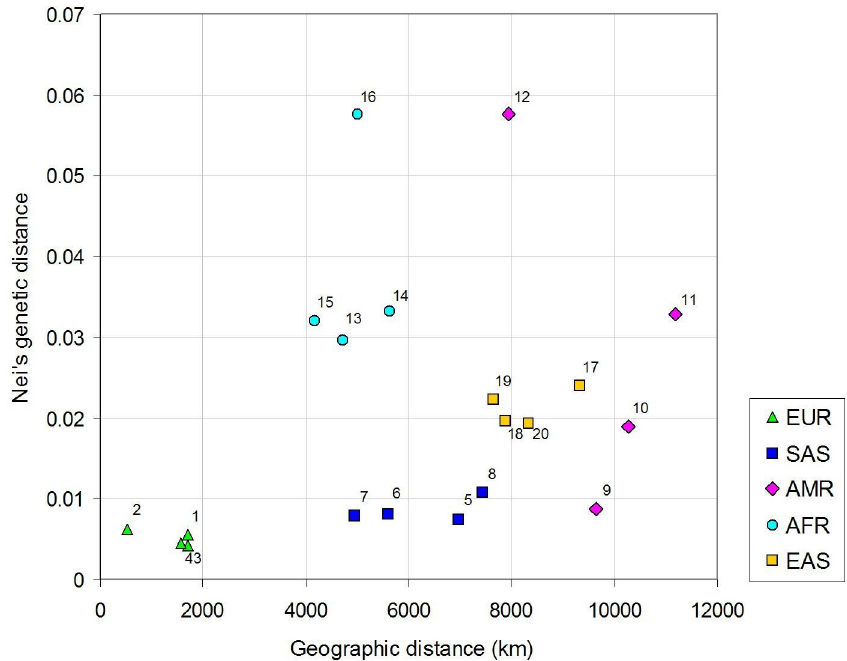
Fig 2. Genetic distances between the Croatian Roma and 20 populations worldwide in relation to their geographic distances. Legend: 1 = Finland; 2 = Italy; 3 = Spain; 4 = UK; 5 = Bangladesh; 6 = India; 7 = Pakistan; 8 = Sri Lanka; 9 = Colombia; 10 = Mexico; 11 = Peru; 12 = Puerto Rico; 13 = Gambia; 14 = Kenya; 15 = Nigeria; 16 = Sierra Leone; 17 = Japan; 18 = China–Dai; 19 = China–Han; 20 =